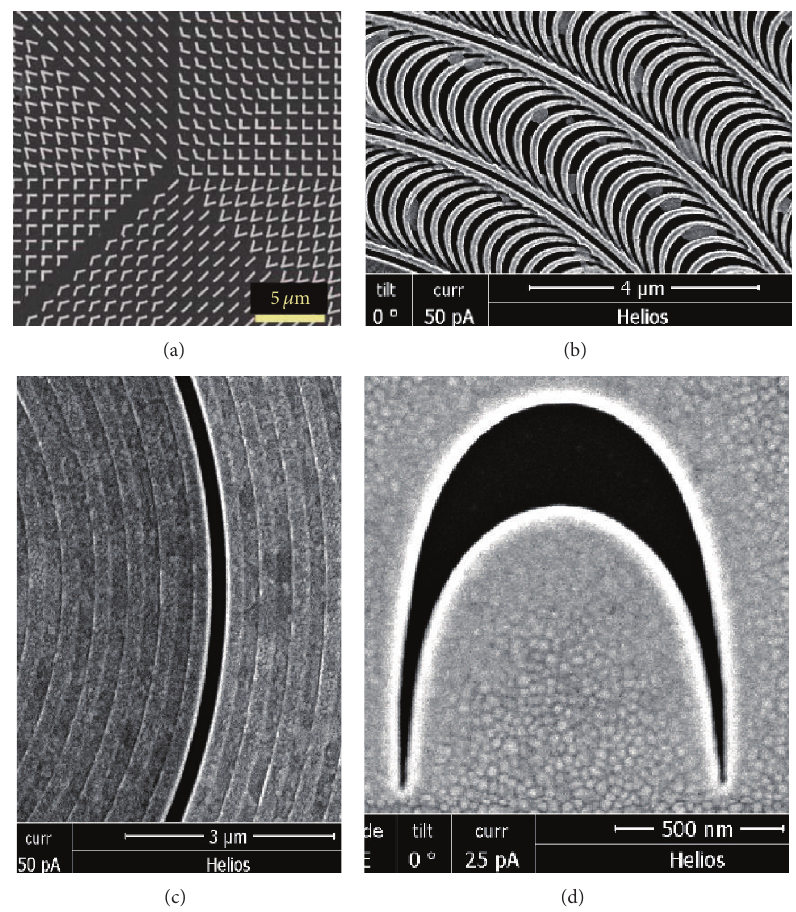
Figure 52: Typical fabricated metasurfaces at optical frequencies via EBL and FIB. Figures are reproduced from (a) [134], (b) [172], and (c) and (d)